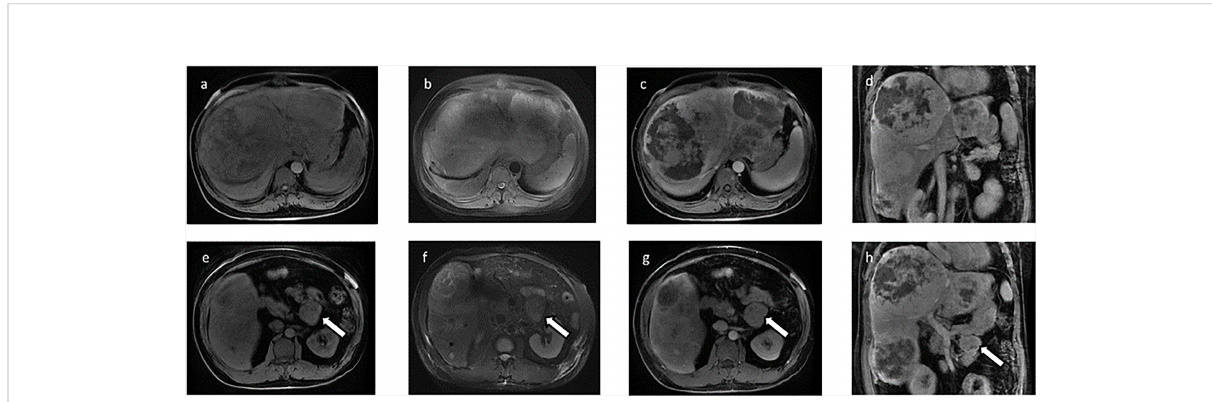
FIGURE 1 Contrast-enhanced magnetic resonance imaging (MRI) of the liver before TILA-TACE. Contrast-enhanced MRI of the liver showed at least six large masses in the liver, the largest one of which was approximately 14 cm in diameter. All of the masses demonstrated a slightly low mixed signal on T1WI (A) and a slightly high mixed signal on T2WI (B) ; after contrast, all these masses were clearly enhanced (C , D) . In addition, a mass located in the tail of the pancreas that measured 3.6 cm in diameter was observed (arrow), with short T1 (E) and long T2 (F) signals on MRI, and the mass was evidently enhanced after contrast (G , H)